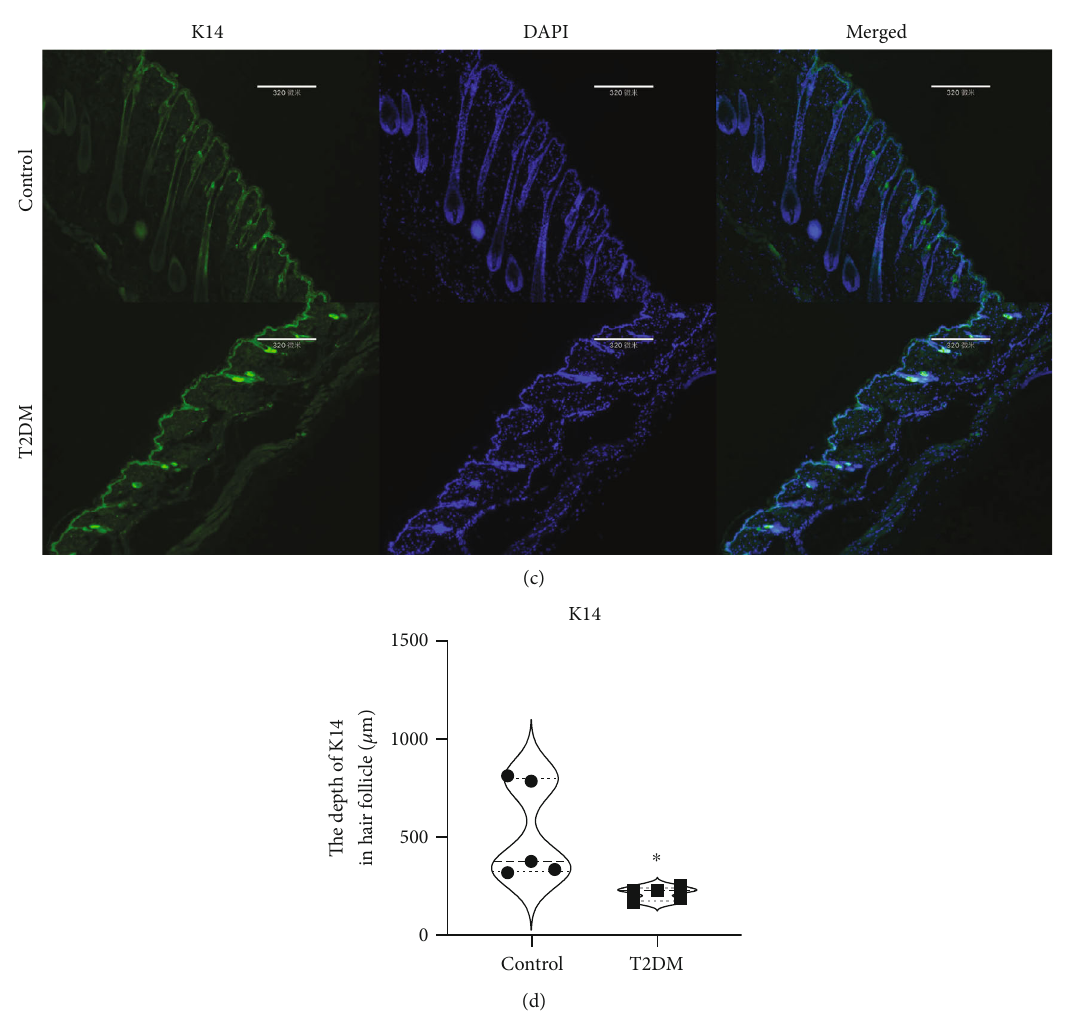
Figure 2: T2DM inhibits skin cells proliferation. (a) Representative photos of PCNA in the skin. (b) T2DM decreased the PCNA expression in hair follicles (control 13 : 31 ± 3 : 428 vs. T2DM 8 : 462 ± 5 : 272 , brown area %, P = 0 : 0204 , n = 5 ) and epidermis (control 14 : 4 ± 3 : 387 vs. T2DM 9 : 2 ± 5 : 45 , brown dot per 100 μ m, P = 0 : 0387 , n = 5 ). (c) Representative photos of K14 and DAPI staining in skin. (d) T2DM reduced the depth of K14 in hair follicles (control 525 : 8 ± 250 : 5 vs. T2DM 212 : 2 ± 36 : 23 , μ m, P = 0 : 0353 , n = 5 ). ∗ P < 0 : 05